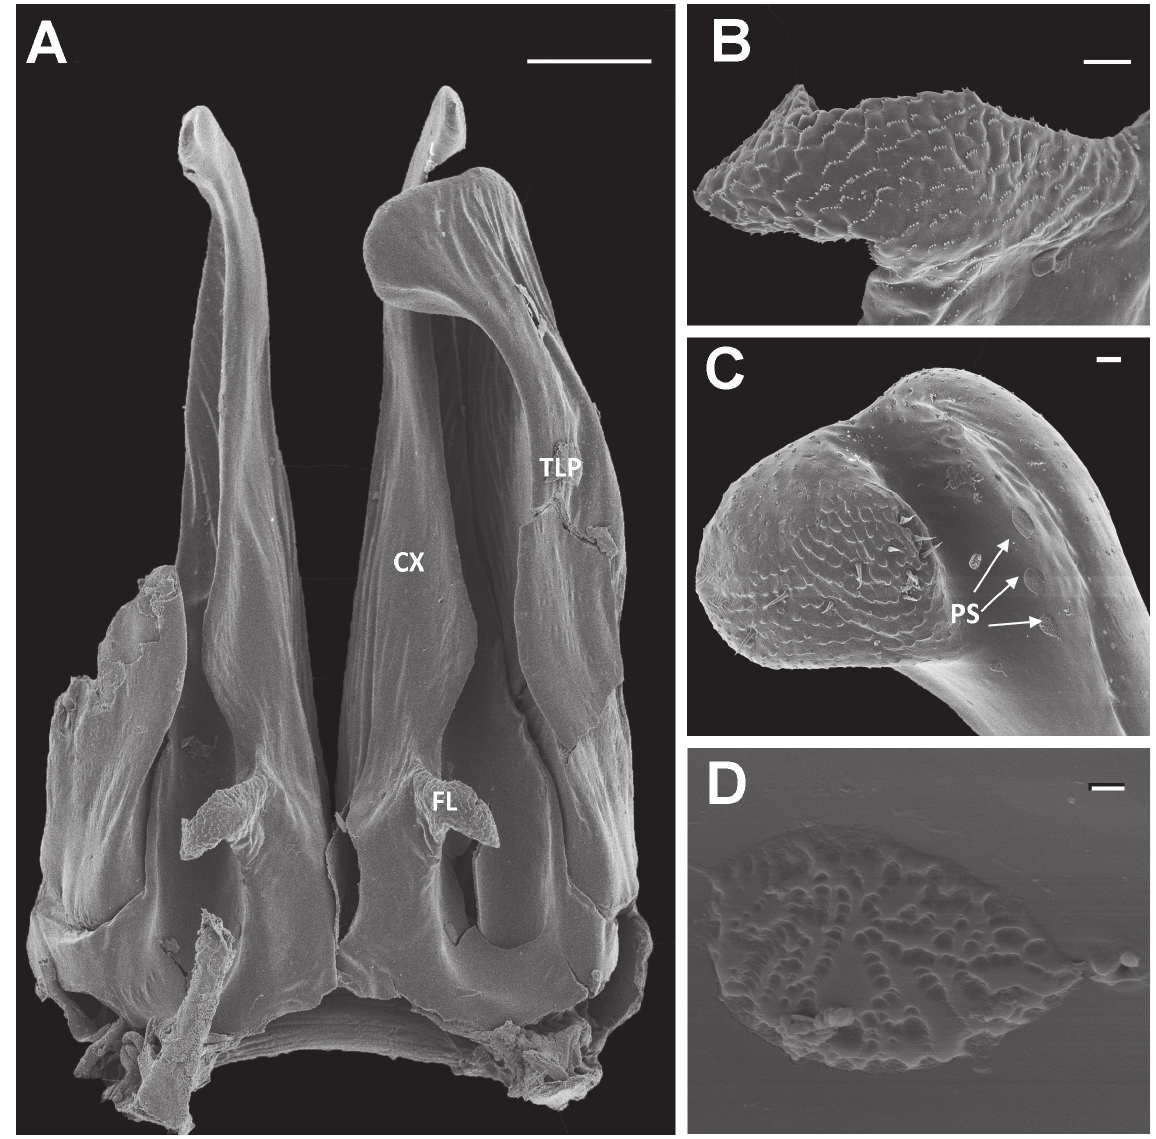
Fig. 7. Koiulus interruptus gen. et sp. nov., paratype, ♂, from the upper course of the river Ko, anterior gonopods. A . Posterior view. B . Modified flagellum. C . Tip of left telopodite. D . Porose structure from telopodite. Abbreviations: CX = coxal process; FL = flagellum; PS = porose structure; TLP = telopodite. Scale bars: A = 0.1 mm; B–C = 0.01 mm; D = 0.001